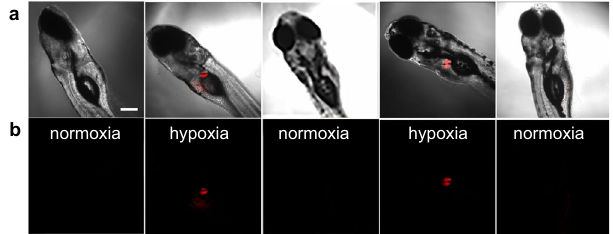
Fig. 5 Reversible hypoxia imaging in zebra fi sh. Confocal imaging of a 6- day-old zebra fi sh embryos injected with 2 nL HDSF (2 μ M). Images were collected for zebra fi sh embryos underwent water rinse (normoxia) and BDM (15 mM, 5 min) treatment (hypoxia) successively in cycle. a Overlaps of bright fi eld and fl uorescence images, b fl uorescence images. The results are representative of three biologically independent experiments. λ ex , 633 nm. Scale bars: 200 μ m.